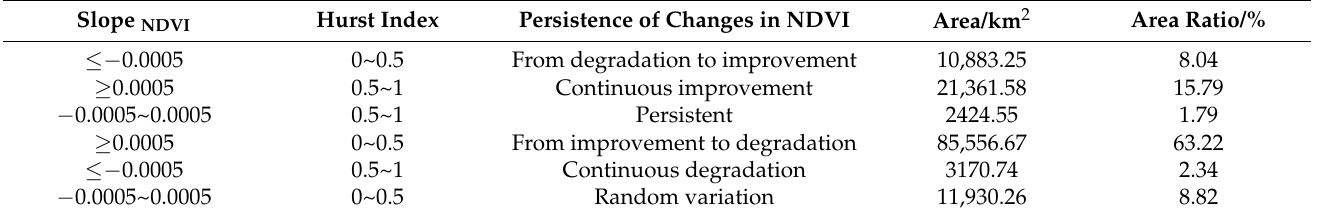
Table 3. Classification table of NDVI change